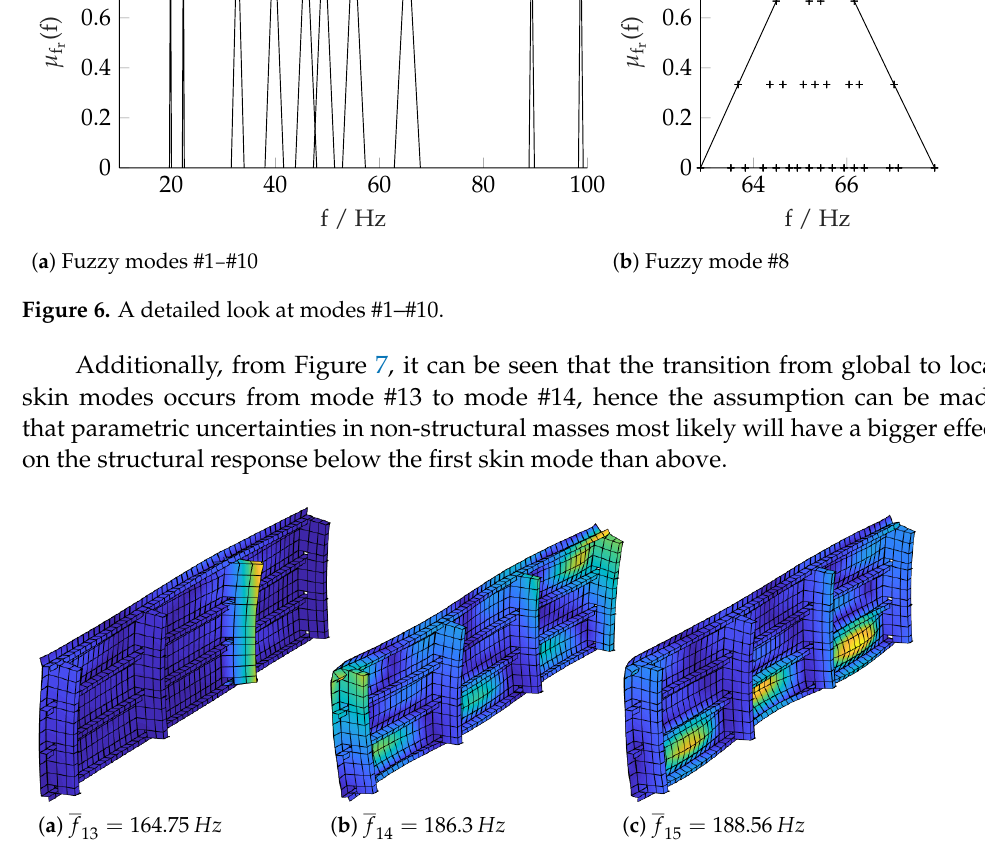
Figure 7. Modeshapes #13 to #15